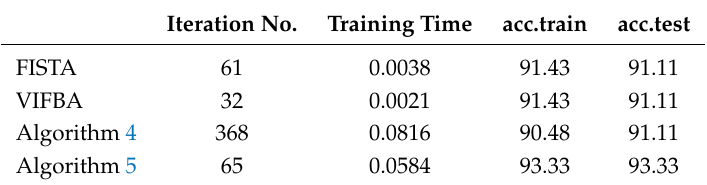
Table 11. The performance of each algorithm with the stopping criteria. Iteration